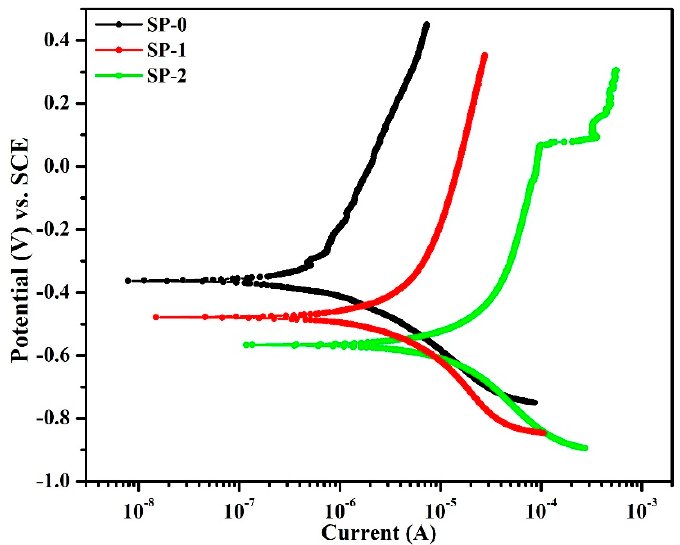
Figure 7. Potentiodynamic polarization after 168 h immersion in different